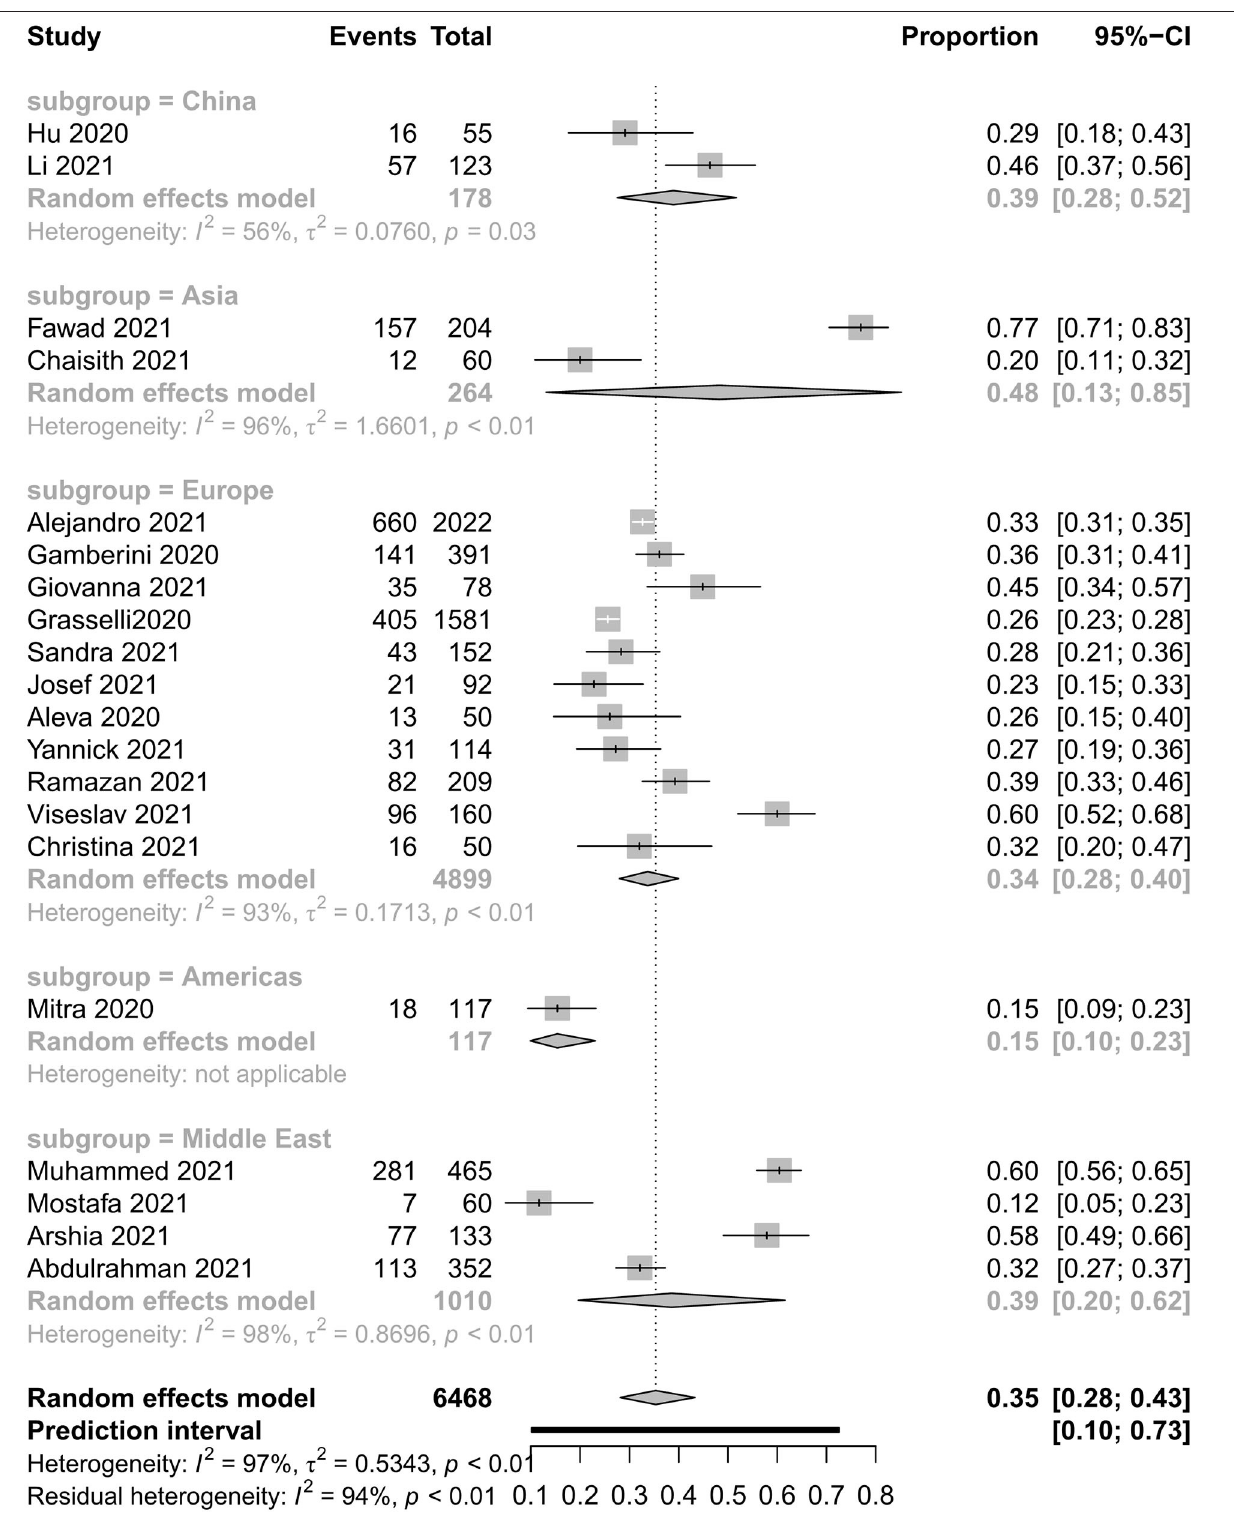
FIGURE 2 | All-cause mortality in intensive care unit with COVID-19.